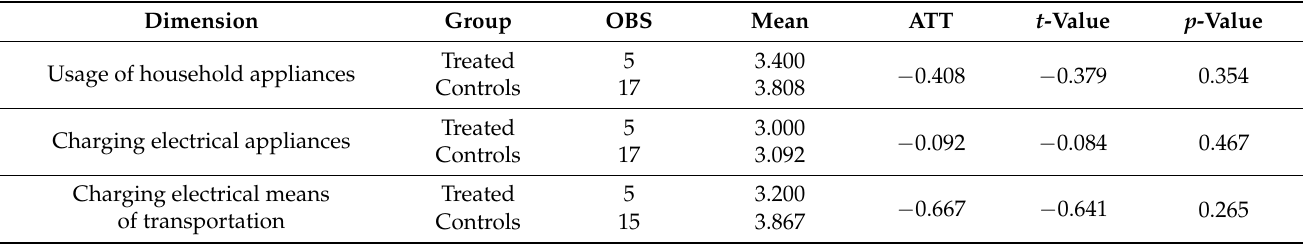
Table 3. Demand flexibility comparisons of Biogas-owners (treated) versus Non-Owners (controls) (source: authors’ own calculations).